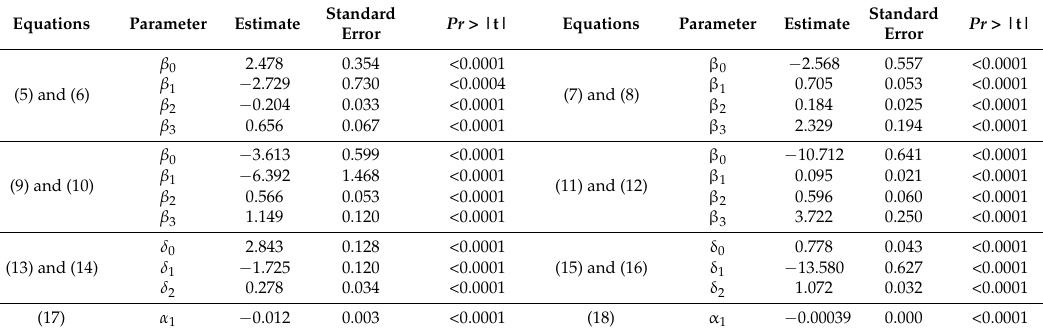
Table 4. Estimated parameters of prediction and projection models.